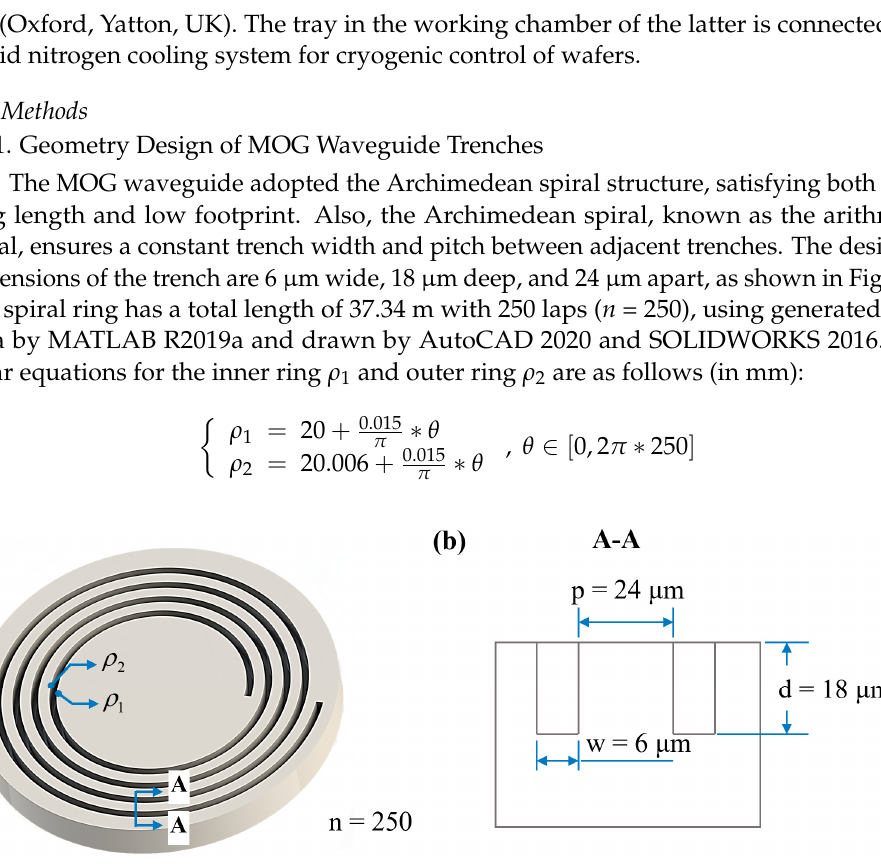
Figure 1. MOG spiral trenches: ( a ) 3D structure diagram and ( b ) geometry